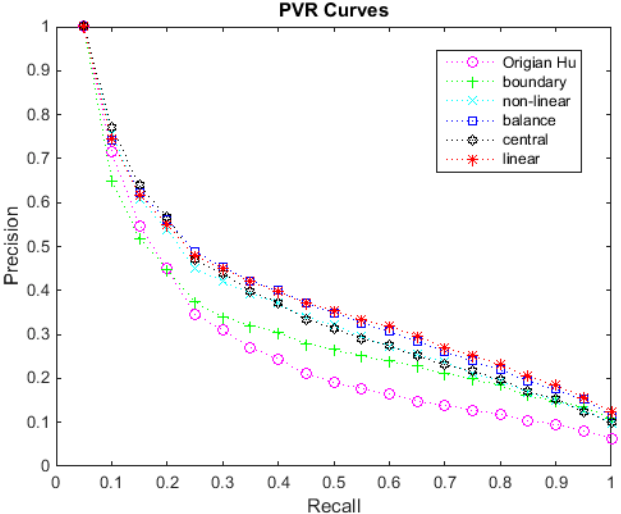
Figure 3. Average retrieval precision-recall curves on MPEG-7 shape database.